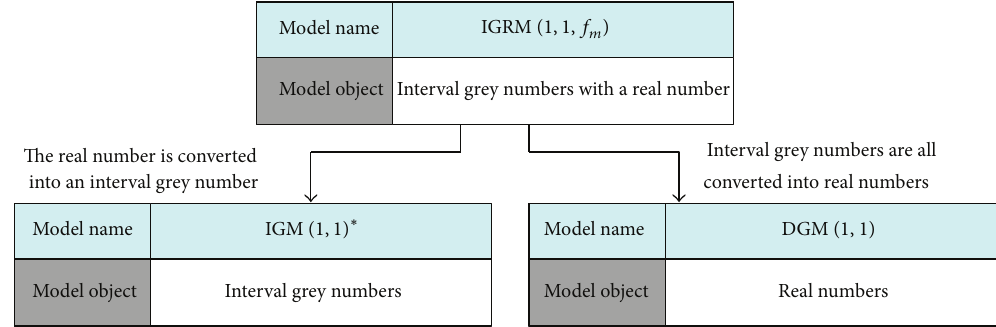
Figure 5: Relationships among IGRM (1,1, 𝜙 𝑚 ) , IGM (1,1) , and DGM (1, 1) .